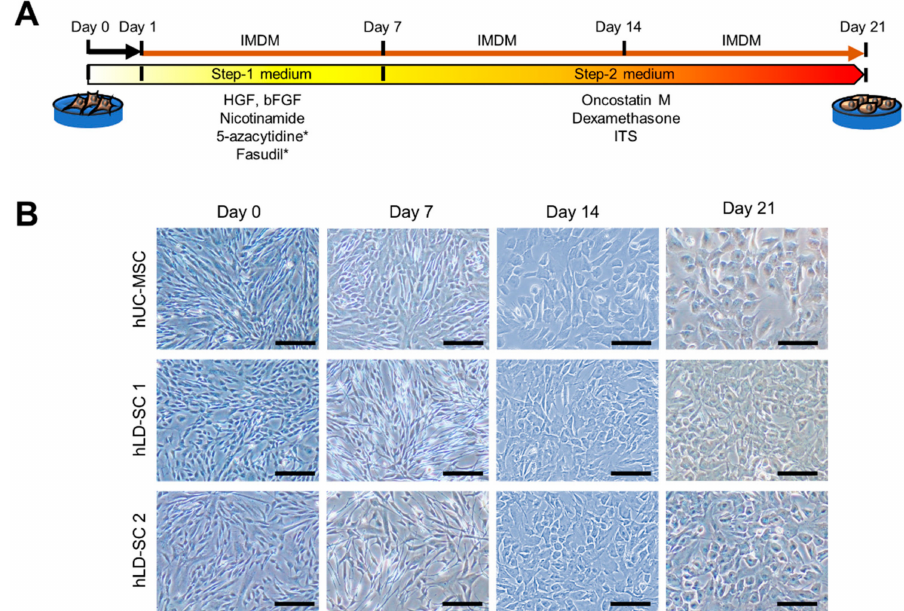
Figure 2. Modified two-step hepatic di ff erentiation for stem cells changed hLD-SCs into those with a hepatocyte-like morphology. ( A ) Schematic summary of the methods for inducing two-step directed di ff erentiation of stem cells into hepatocyte-like cells. *, small molecules. ( B ) Microscopic measurement during two-step hepatic di ff erentiation. The hUC-MSCs and two hLD-SCs were measured. Cells on days 0, 7, 14, and 21 of hepatic di ff erentiation are displayed. Scale bar, 200 µ